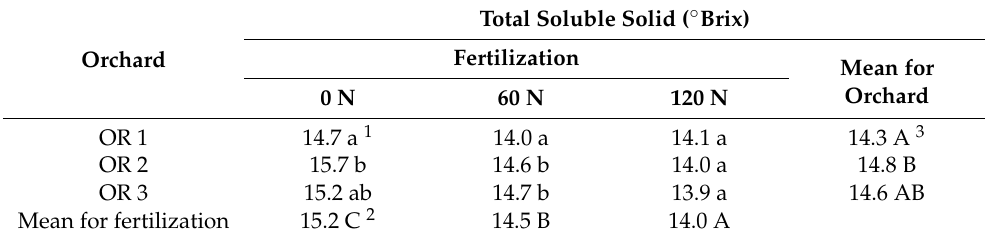
Table 8. Influence of fertilization on TSS content of sour cherry fruit cv. ‘Łut ó wka’ in the years 2006–2013.